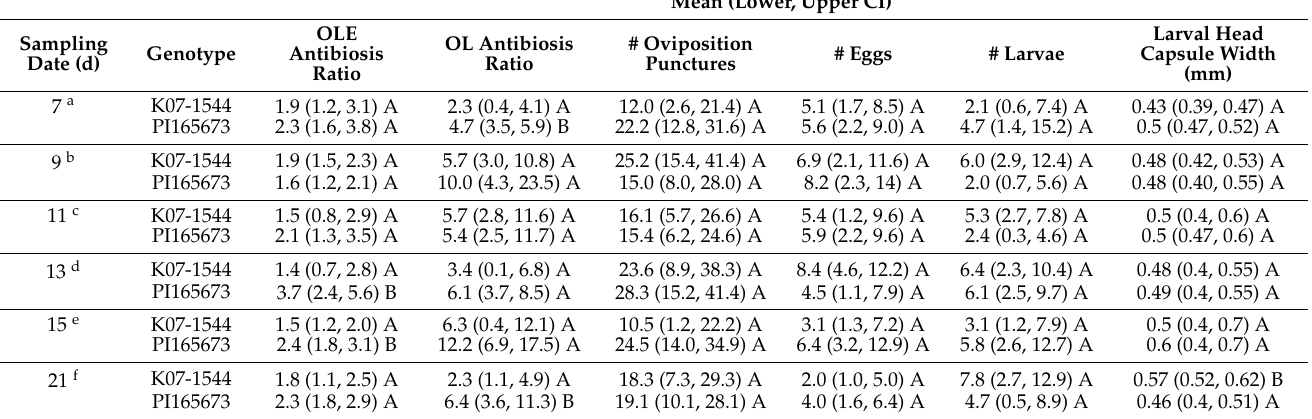
Table 5. Mean (lower, upper CI) OEL and OL antibiosis ratios; numbers of oviposition punctures, numbers of larvae, numbers of eggs, and larval head capsule width per plant in soybean genotypes K07-1544 and PI165673 infested with Dectes texanus in